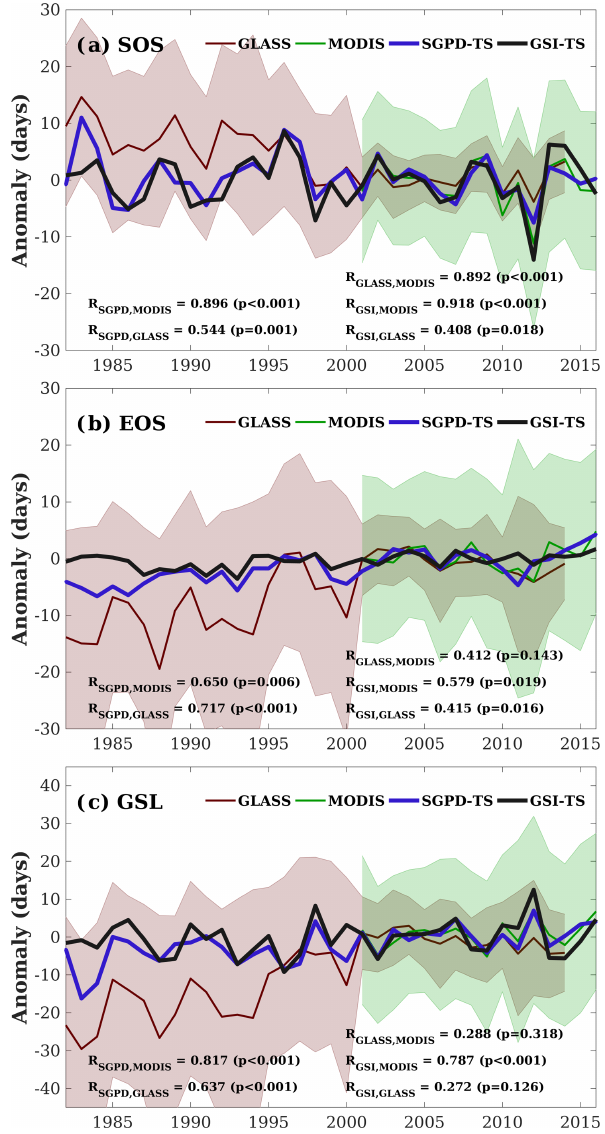
Figure 6. The spatially averaged phenology anomalies relative to the 2001–2010 average are shown for (a) the start of the season (SOS), (b) the end of the season (EOS), and (c) the growing sea- son length (GSL). SOS and EOS are derived as the date on which LAI first and last reaches 50% of the seasonal amplitudes and GSL is derived as the difference between EOS and SOS. The shaded ar- eas denote the standard deviation of the corresponding phenophases across